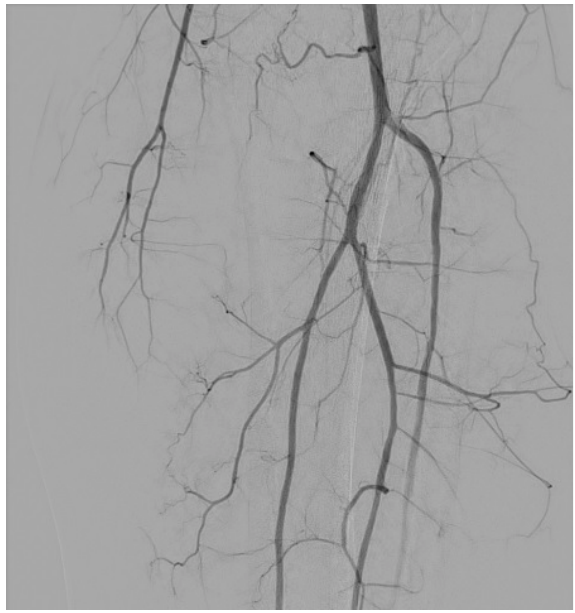
Radiation 2022 , 2 , FOR PEER REVIEW Figure 2. Frontal DSA acquisition showing physiological appearance of tibio-peroneal trunk.